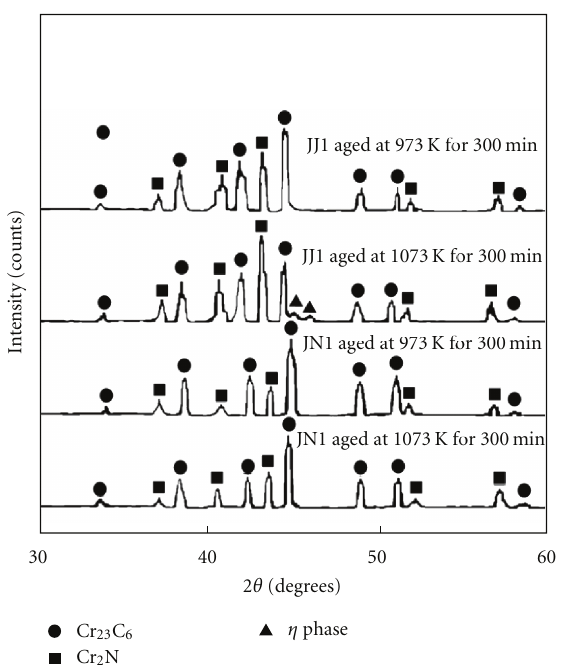
Figure 2: XRD patterns of the JJ1 and JN1 steels aged at 973 and 1073 K for 500 min.